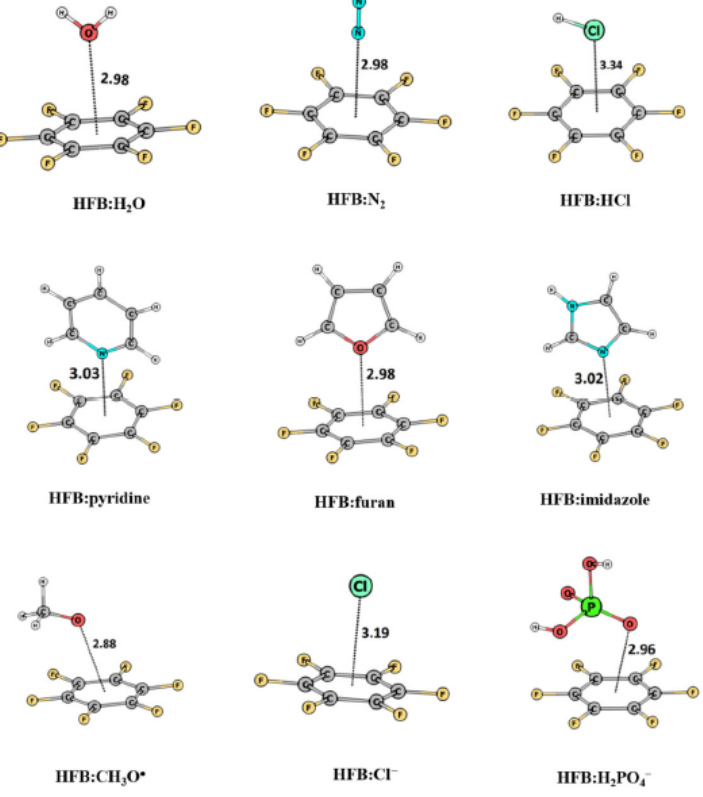
Figure 11. Hexafluorobenzene (HFB)-lone pair complexes along with the indicated interaction distances in Å at M06L/6-311++G (d, p) calculations. See text for